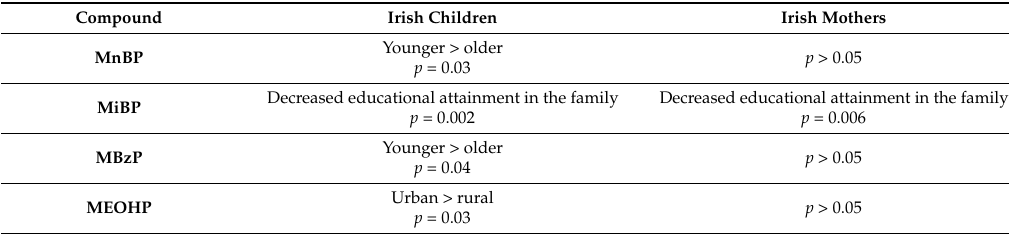
Table 4. Association between phthalate exposure and sociodemographic variables * .